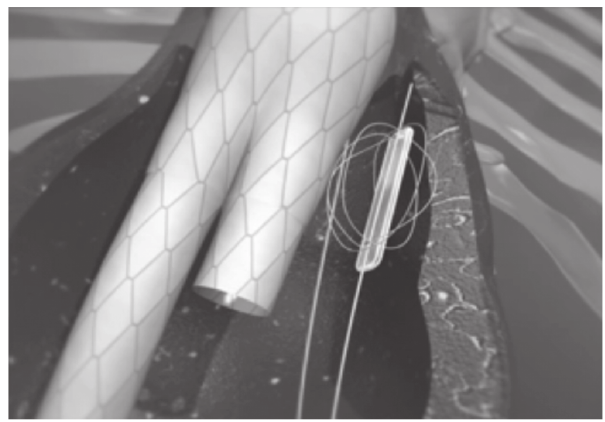
Figure 3 – The technique employed for determining intra-sac pressure, Reading 1. Placed within the sac are the angiographic catheter and, nearby, the pressure sensor.